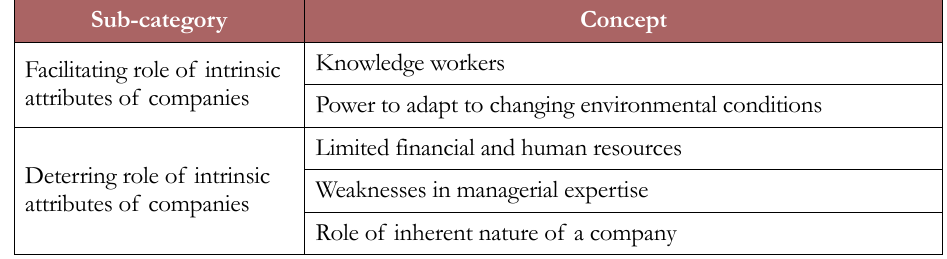
Table 4. Concepts and sub-categories of intervening conditions